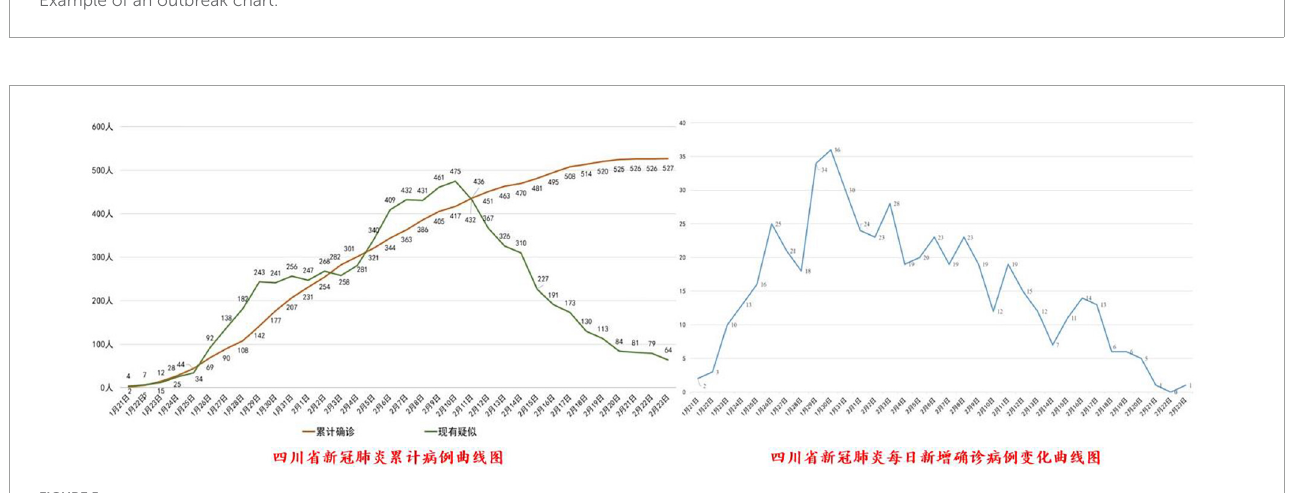
FIGURE5 Example of an outbreak